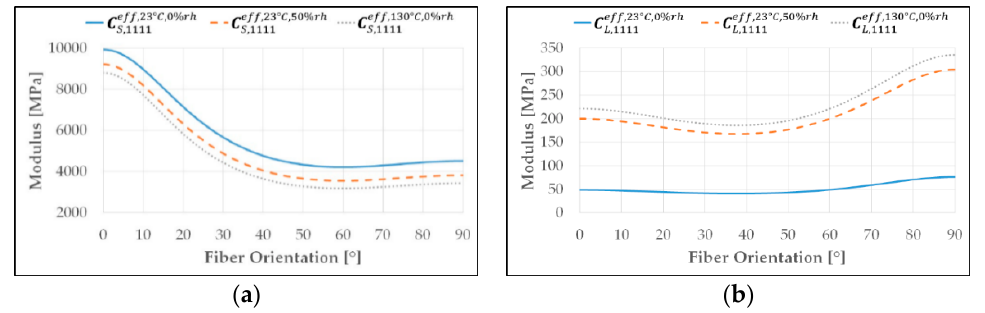
Figure 10. Components of the fourth ranked ( a ) stiffness and ( b ) damping tensors of PA66 ‐ GF30 at 23 °C and 0% rh, 23 °C and 50% rh, 130 °C and 0% rh.